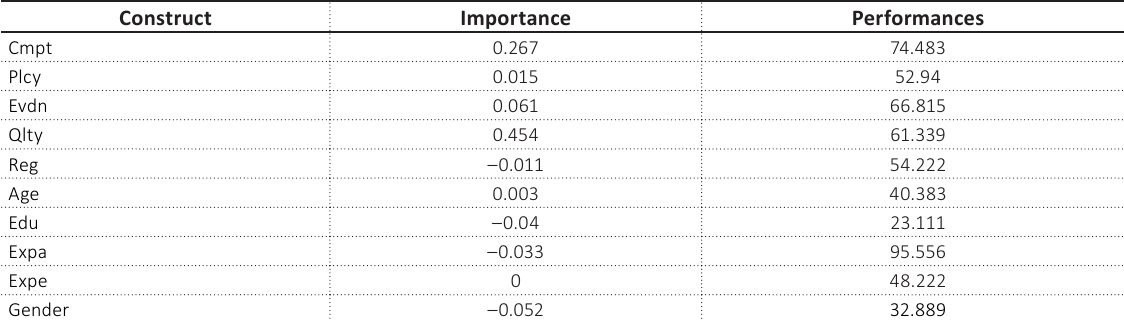
Table 5. Importance-performance results